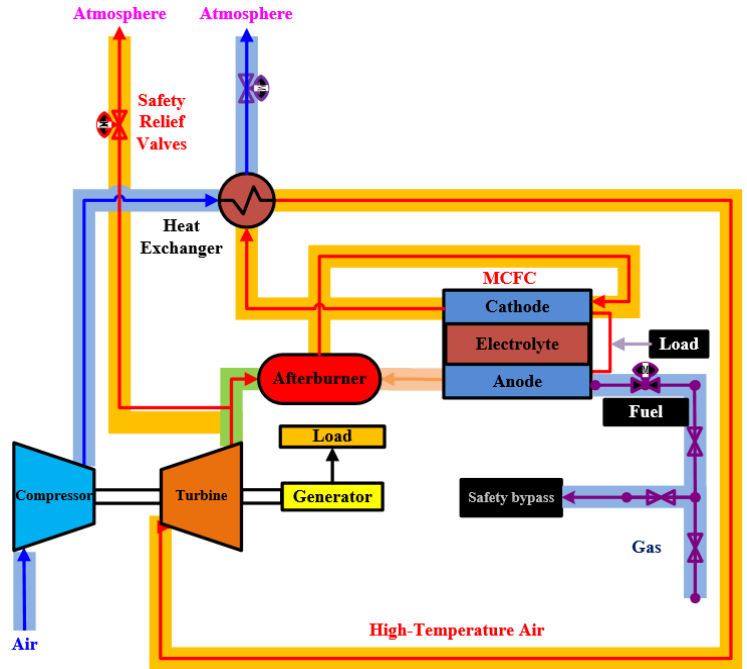
Figure 1. Molten Carbonate Fuel Cell-Micro Gas Turbine (MCFC-MGT) hybrid power system diagram.